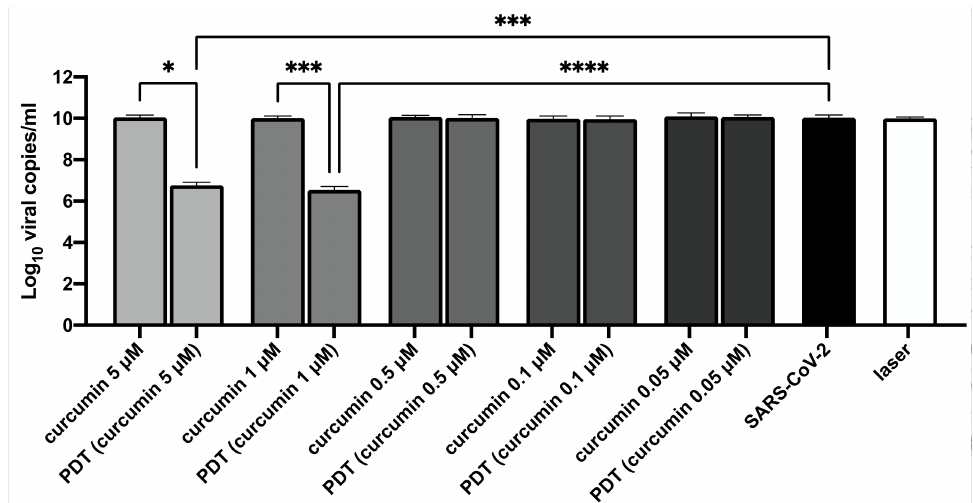
Figure 4. Results of photodynamic treatment (PDT) with different concentrations of curcumin (5, 1, 0.5, 0.1, and 0.05 µ M) on SARS-CoV-2 infectivity (viral load) on day 7 post-treatment/infection. The data obtained through the irradiation of the virus without curcumin (indicated as “laser” in the figure), the treatment of the virus with curcumin without irradiation (designed as “curcumin”), and the non-treated virus (not irradiated and not challenged with curcumin, indicated in the figure as “SARS- CoV-2”) are also reported. The viral load is expressed as Log 10 viral copies for mL. Results of Kruskal– Wallis test, adjusted for Dunn’s multiple comparisons test, are displayed. **** p -value < 0.0001; *** p -value < 0.001; * p -value <